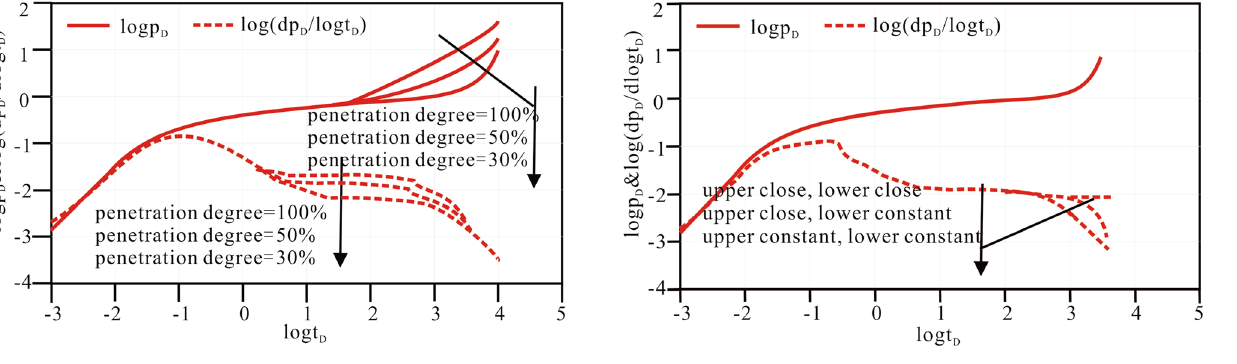
Fig. 9 The effect of opening shot degree on template curves